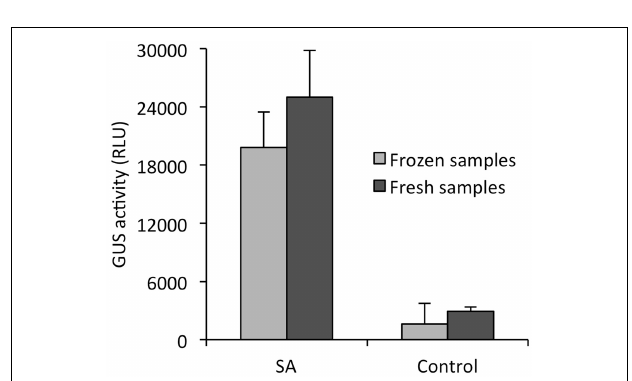
seedlings ( in situ ) and (B) in total extracts ( in vitro ) derived from seedlings of the same experiment. Specific activities are derived from 4-MU standard curves and are normalized to assay volume (A) or total extractable protein (B) . All values represent the mean ( ± SD) of four biological replicates.